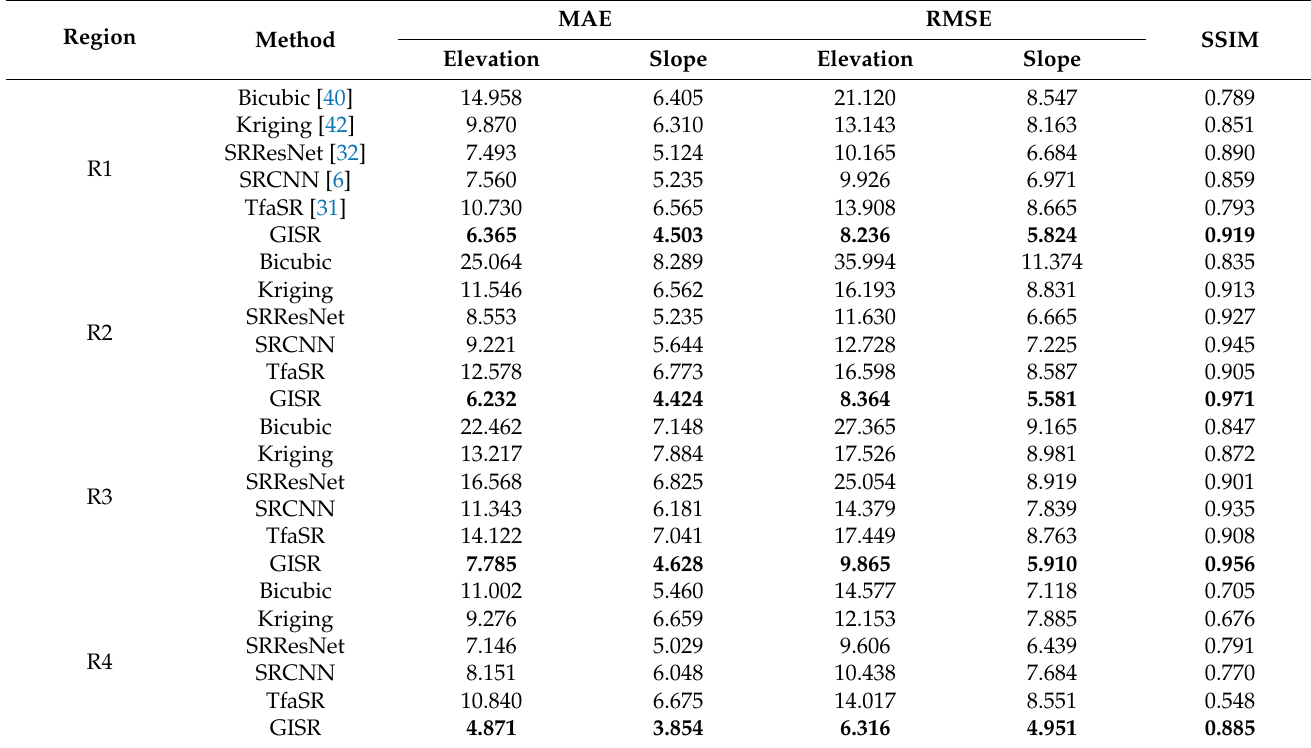
Table 1. The accuracy indicators of different